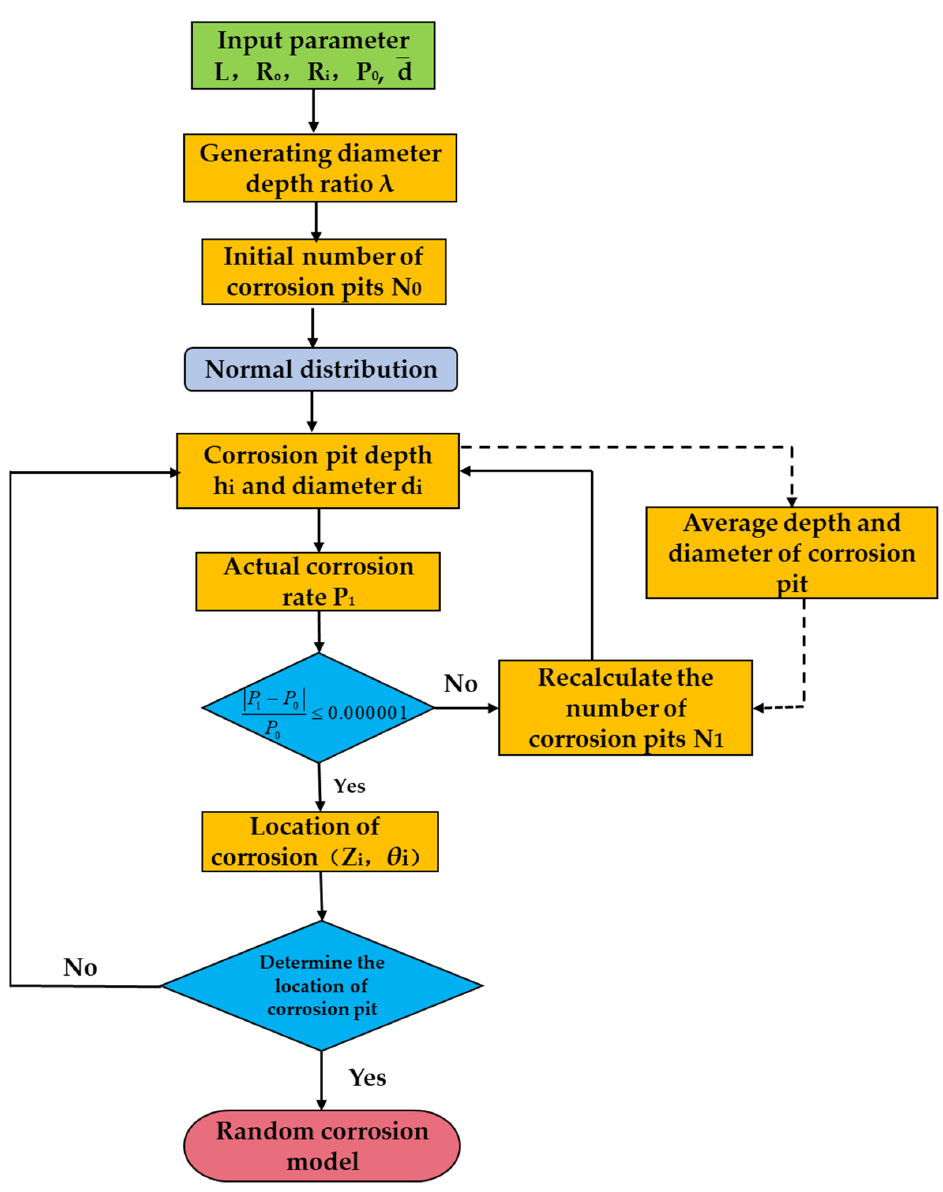
Figure 4. Python program execution process.